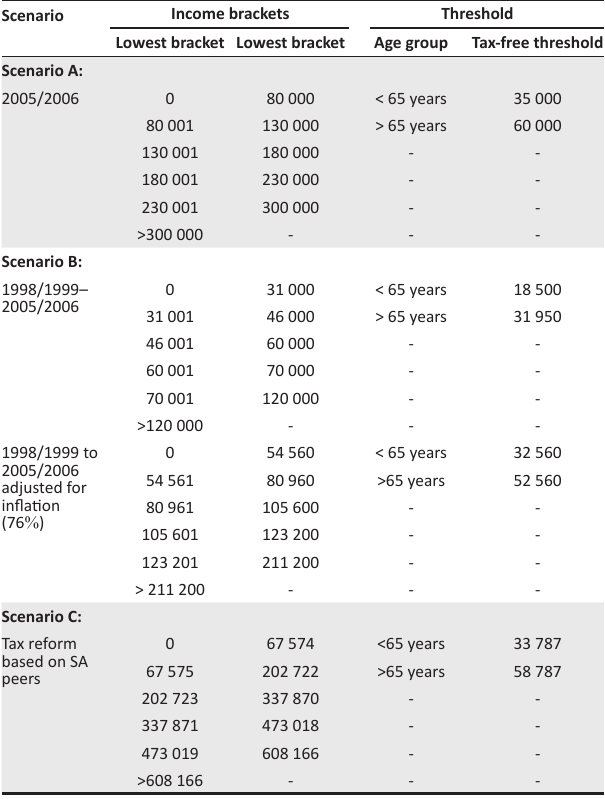
TABLE 5: Income brackets and thresholds of different scenarios.